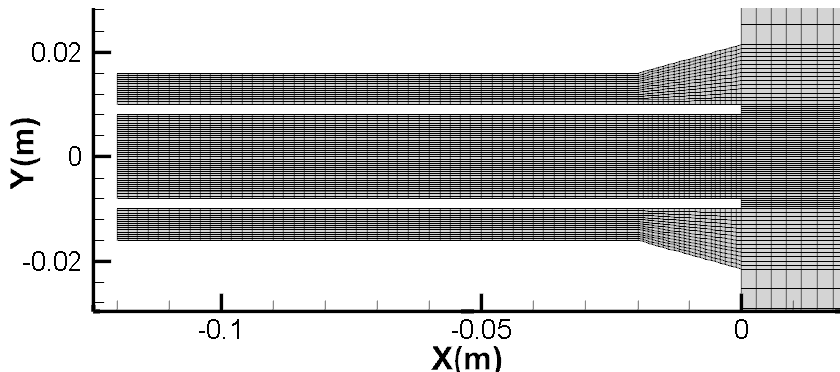
Figure 2. Gridding graph.